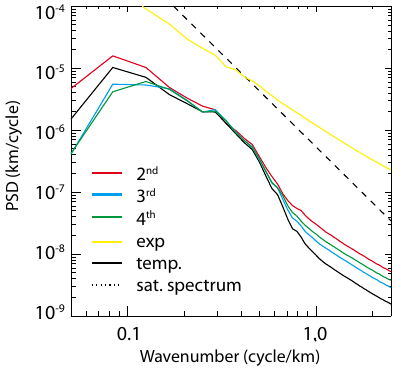
Figure 4. Vertical wave-number power spectral density for the nor- malized density perturbations from different backgrounds and tem- perature normalized perturbations compared with the theoretical saturated